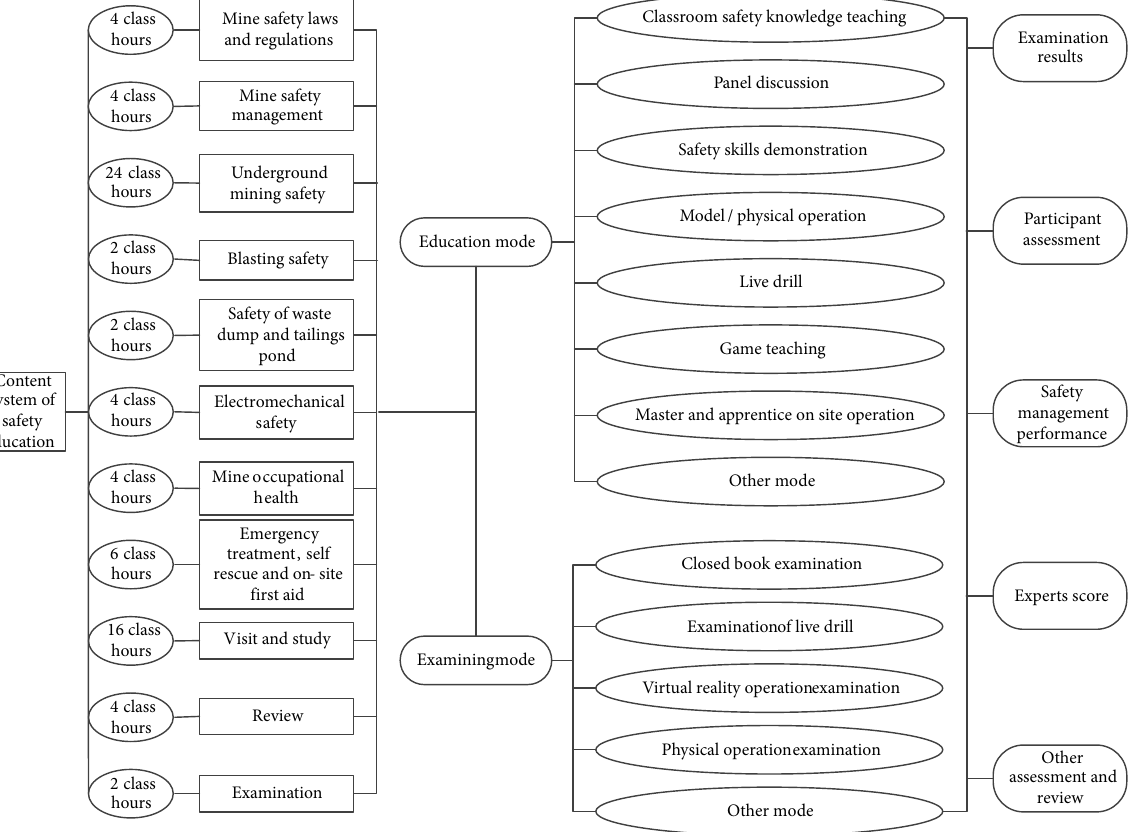
Figure 7. Macro-design of the safety education for employees in metal and nonmetal